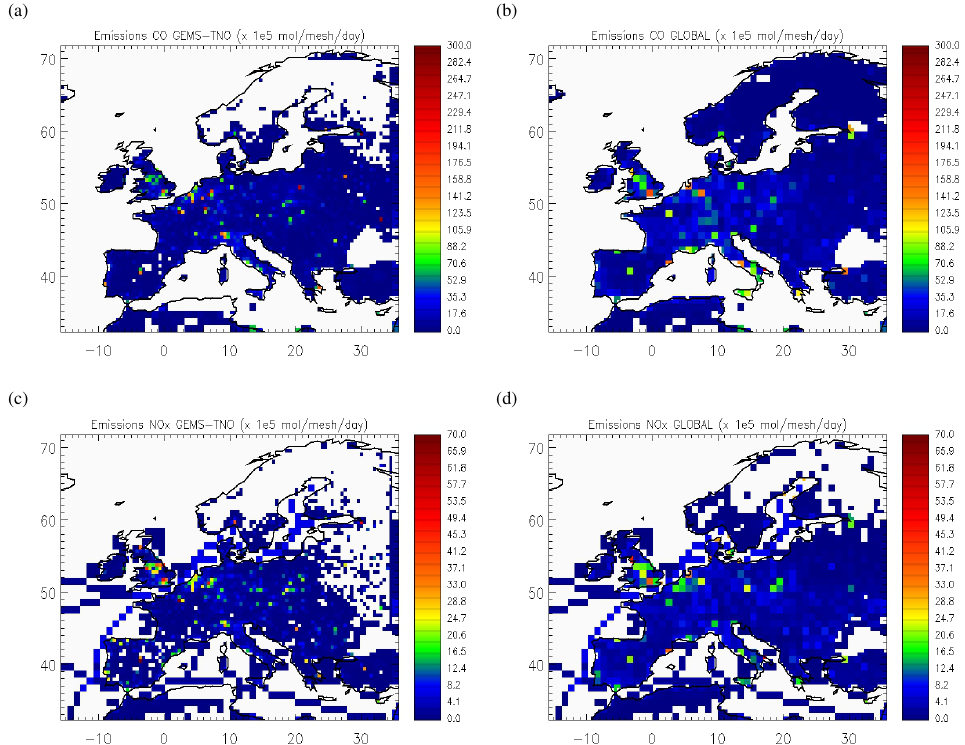
Fig. 1. Total CO emitted by day and by model mesh (0.5 ◦ ) over Europe on 6 July 2009 with GEMS-TNO emission inventory (a) and global emission inventory (b) . (c) and (d) are as (a) and (b) but for NO x =NO+NO 2 .